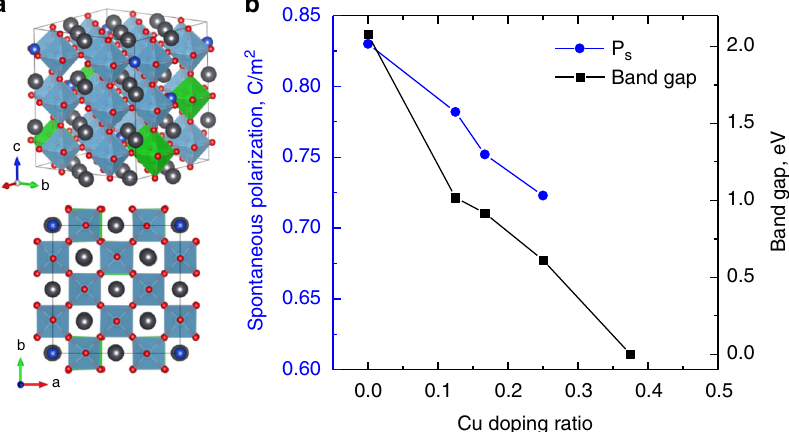
Fig. 5 DFT simulations of Cu-substituted PbZr 0.125 Ti 0.875 O 3 . a Relaxed supercell of Pb 1- x Cu x Zr 0.125 Ti 0.875 O 3 with x = 0.125 (black balls — Pb, blue balls — Cu, red balls — O, blue octahedra — Ti, green octahedra — Zr) and b calculated spontaneous polarization (blue circles) and electronic band gap (black squares) as a function of Cu doping concentration ( x